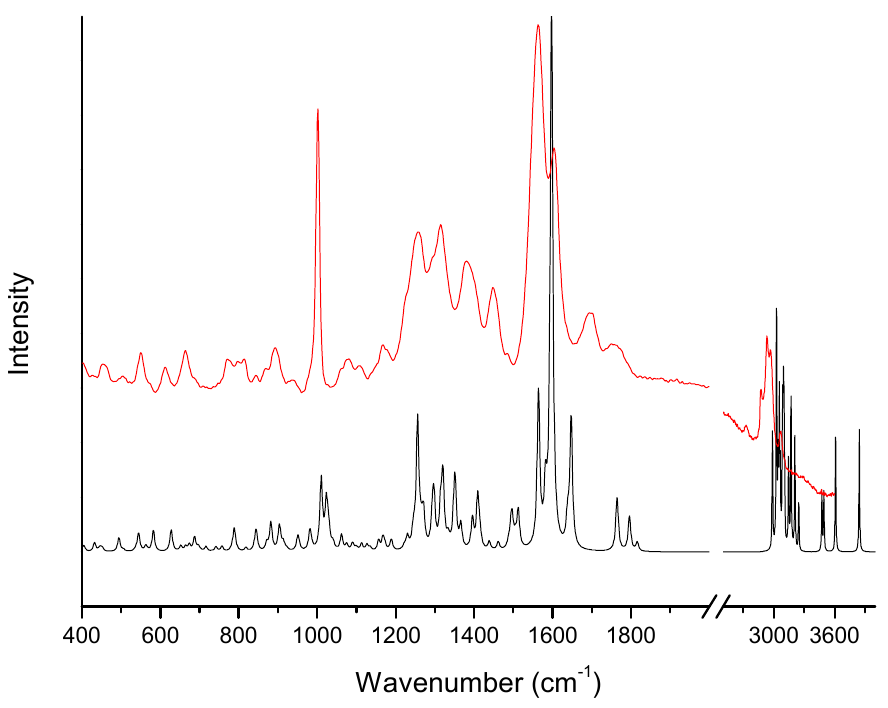
Figure 2. Calculated (black-DFT) and experimental (red) Raman scattering spectra of ertapenem at room temperature.